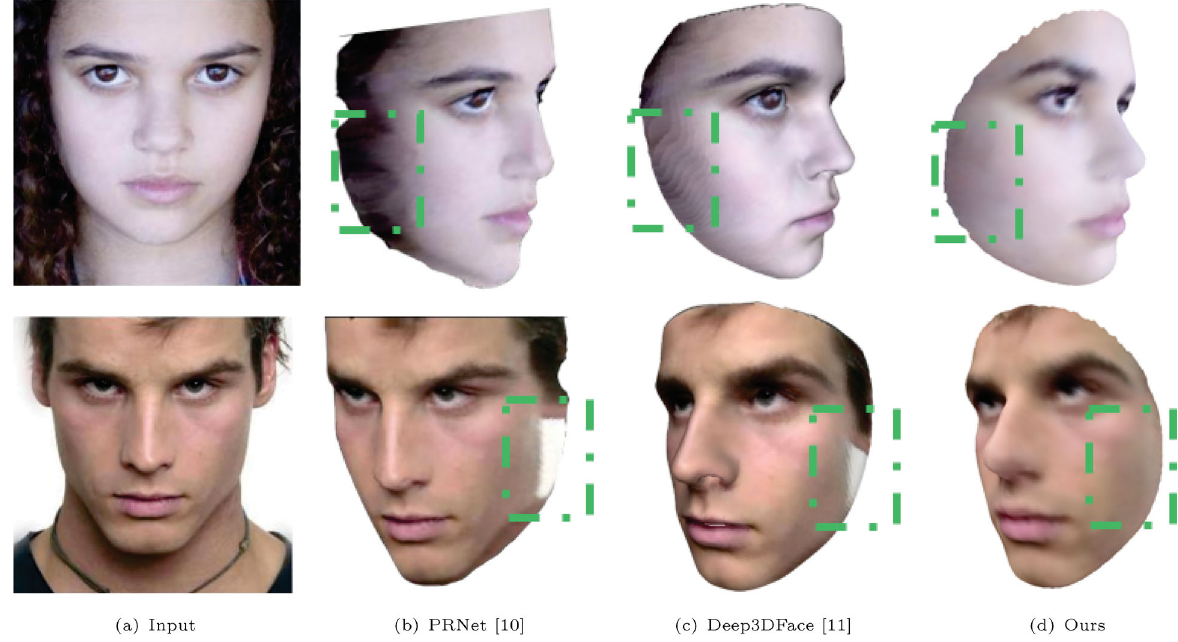
Fig. 1 Examples of correspondences between 2D faces and 3D models provided by PRNet [10], Deep3DFace [11], and our method. PRNet and Deep3DFace produce artifacts caused by inaccurate 2D-to-3D correspondences (green box), while ours does